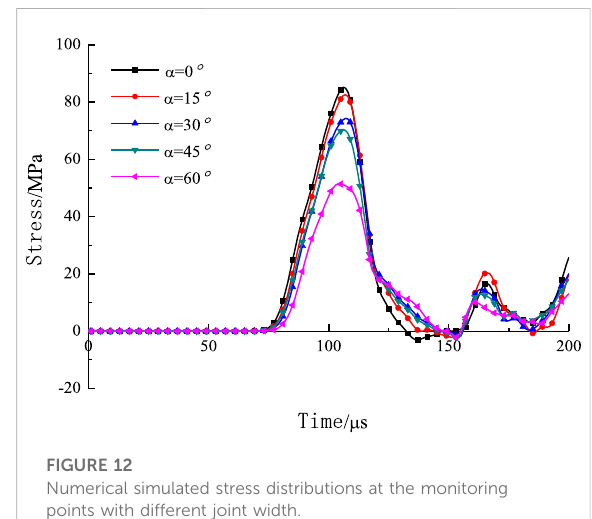
FIGURE 12 Numerical simulated stress distributions at the monitoring points with different joint